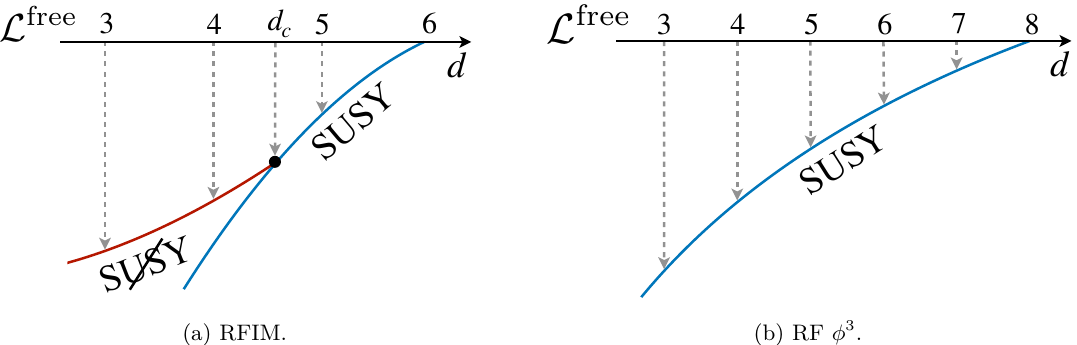
Figure 3 . RG flow of the leader theory in the RFIM (figure 3a) vs RF φ 3 theory (figure 3b). In RFIM we have an unstable SUSY fixed point below d is